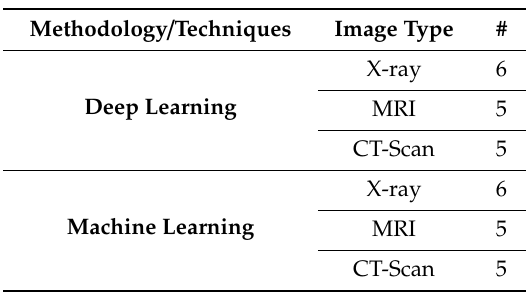
Table 3. Study inclusion